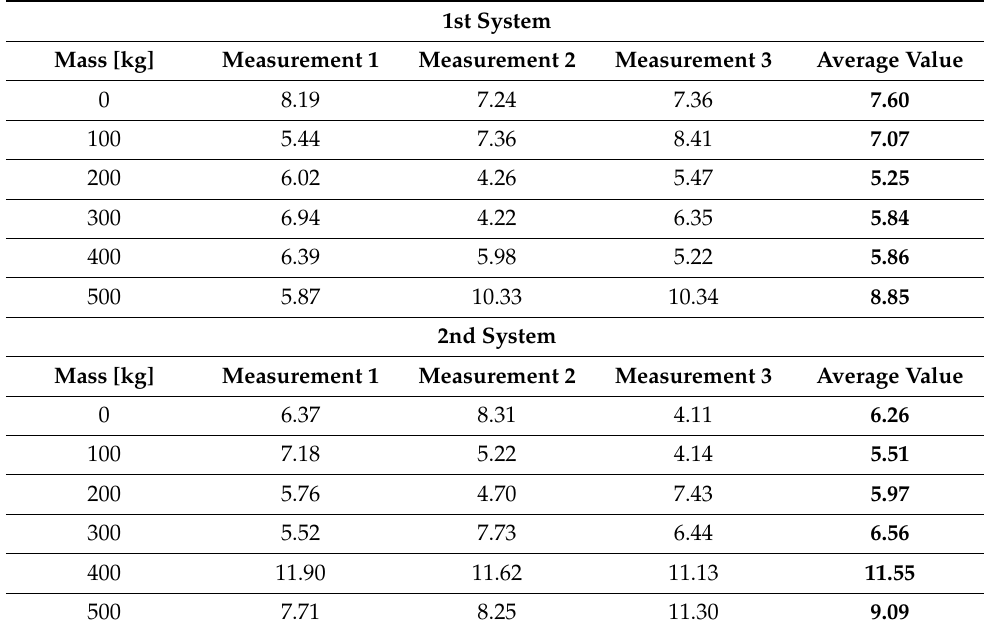
Figure 6. Representative curve of pressure changes in the piston chamber of the cylinder with the indicated maximum value. Table 2. Measurement results of the cylinder displacement after initiating the stopping process, in